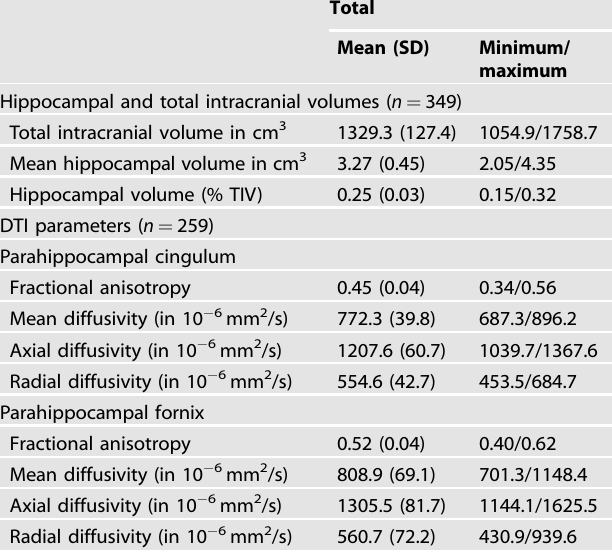
Table 2. Hippocampal volume and white matter integrity of the parahippocampal cingulum and